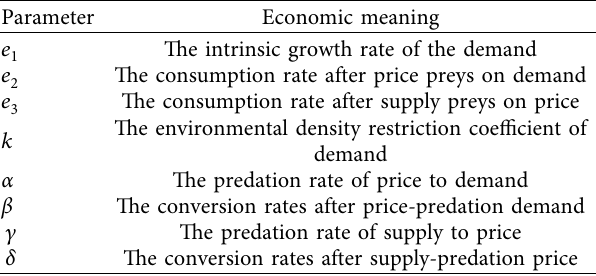
Table 1: Economic meaning of parameters.